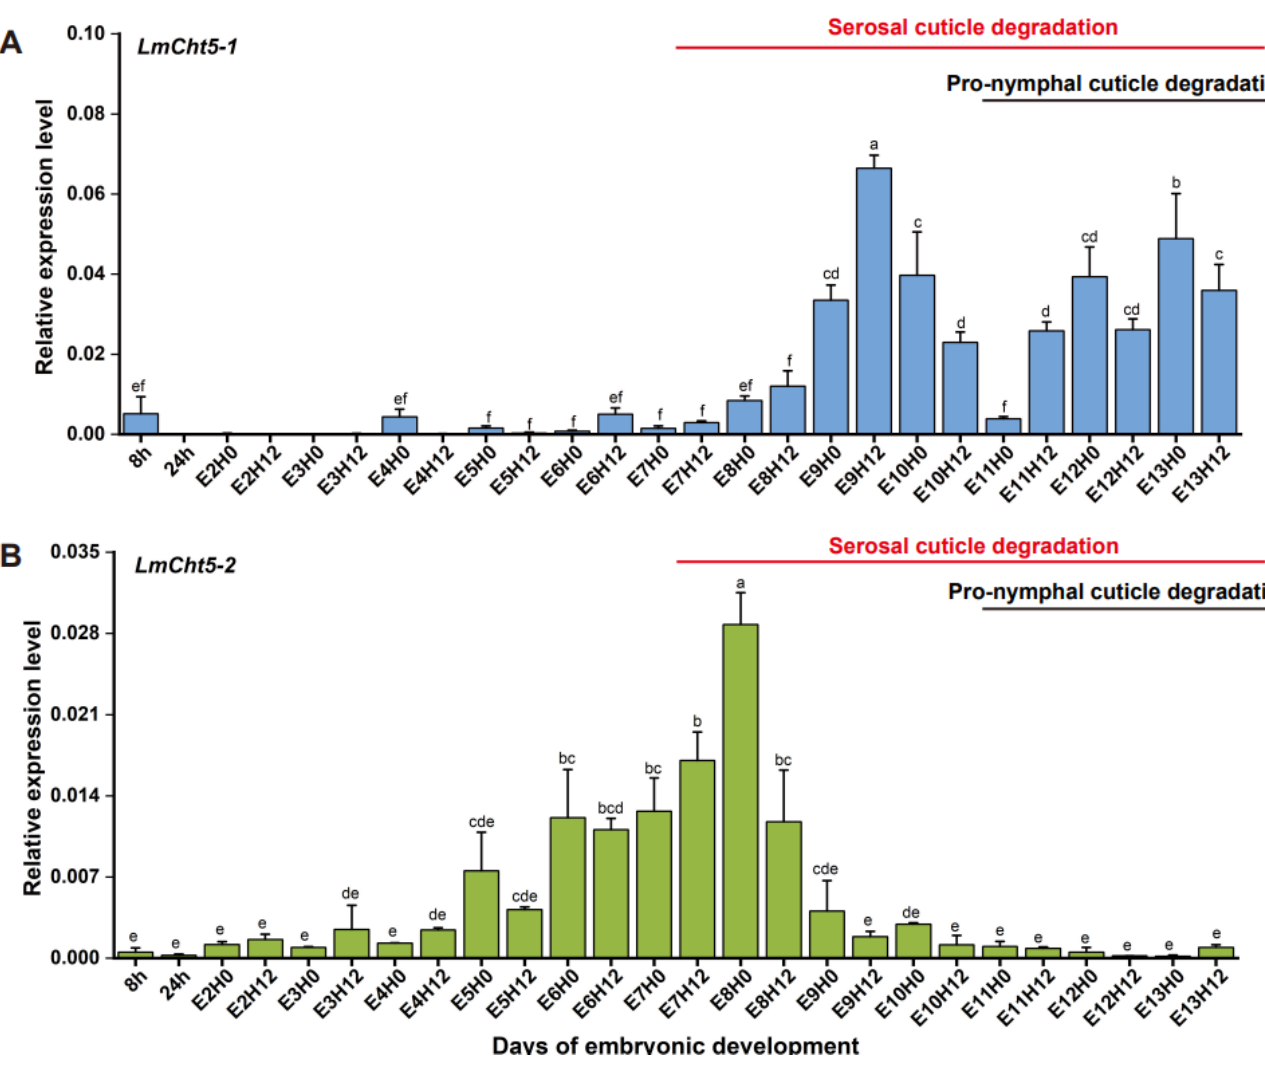
Figure 2. Relative LmCht5-1 and LmCht5-2 mRNA transcript levels during locust embryonic development. RT-qPCR analyses of LmCht5-1 ( A ) and LmCht5-2 ( B ) transcript levels from (8 h) to (E13H12). Data are represented as means ± SE of three independent biological replications. Different letters represent significant differences between the embryonic developmental. (Tukey’s HSD test, p < 0.05). LmRpl32 was used as the reference